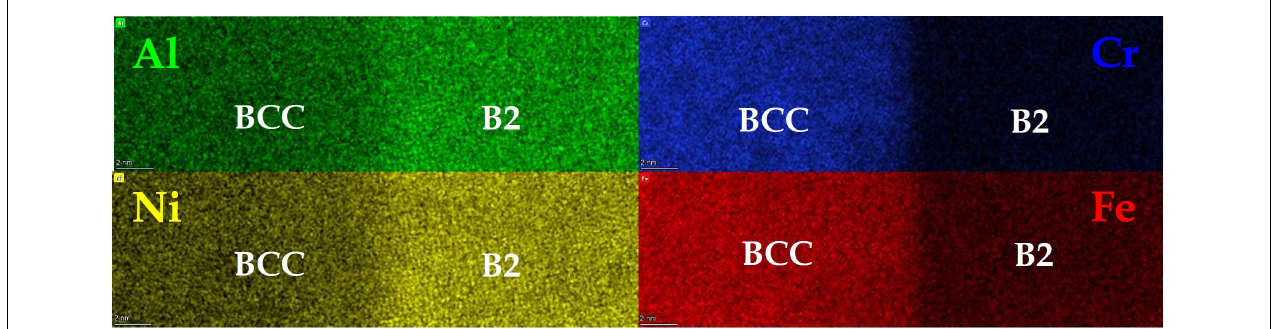
TABLE 1 | Characteristic EDS measurements of phases in as-cast AlCrFe 2 Ni 2 in atomic fractions.